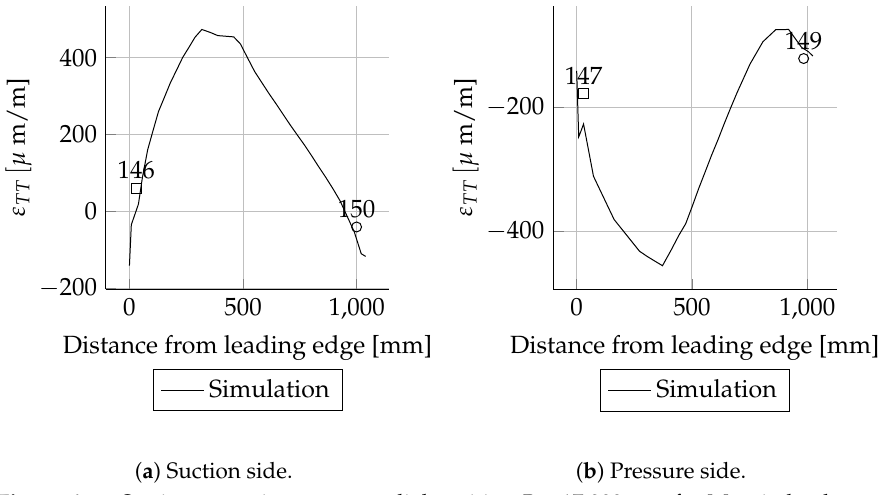
( a ) Suction side. ( b ) Pressure side. Figure A51. Strain comparison ε LL at radial position R = 17,000 mm for Mymin load case.